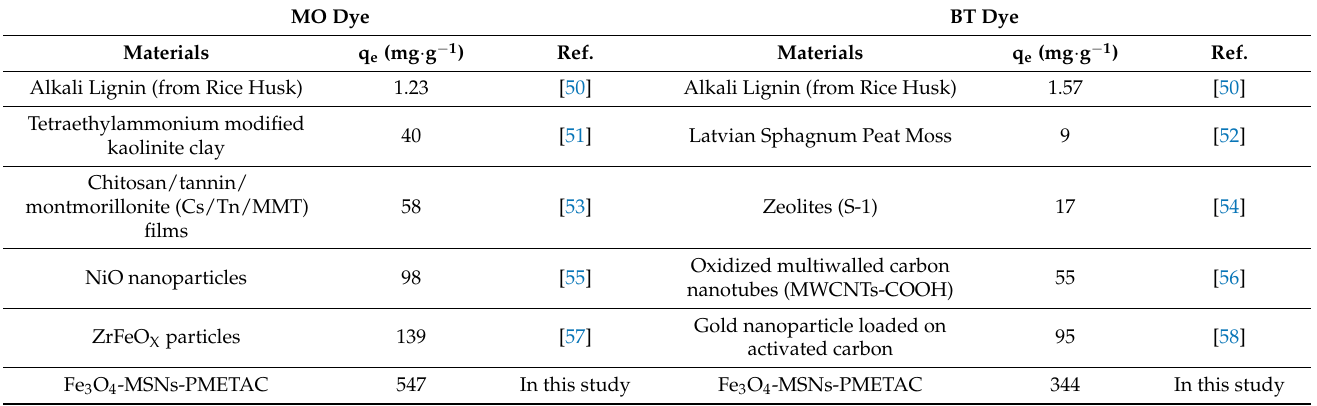
Figure 8. ( a , b ) Pseudo-first-order kinetics for the adsorption of bromothymol blue and methyl orange, respectively, at pH = 7 and 25 ◦ C. ( c , d ) Pseudo-second-order kinetics for the adsorption of bromothymol blue and methyl orange at pH = 7 and 25 ◦ C. ( e , f ) Intraparticle diffusion models for the adsorption of bromothymol blue and methyl orange at pH = 7 and 25 ◦ C. Table 1. Comparison of the amount of methyl orange (MO) and bromothymol blue (BT) adsorbed on different